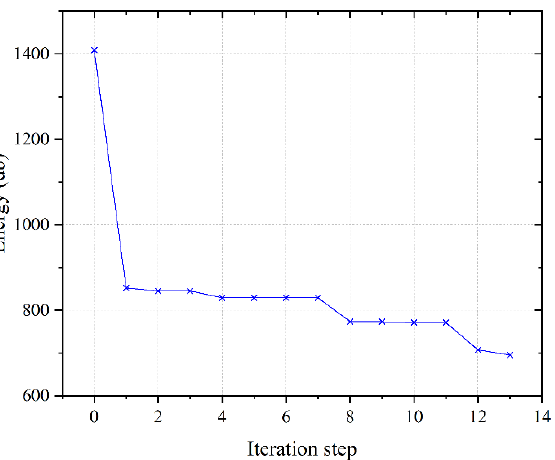
Figure 12. Iterative convergence curve for vibration reduction optimization of the S-shaped curved stiffened shell (FOM).